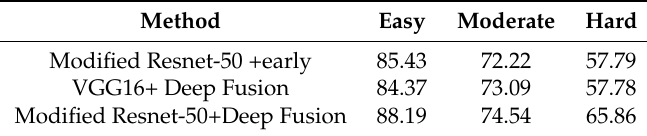
Table 4. Average precision (AP) (in %) for 3D boxes for ablation